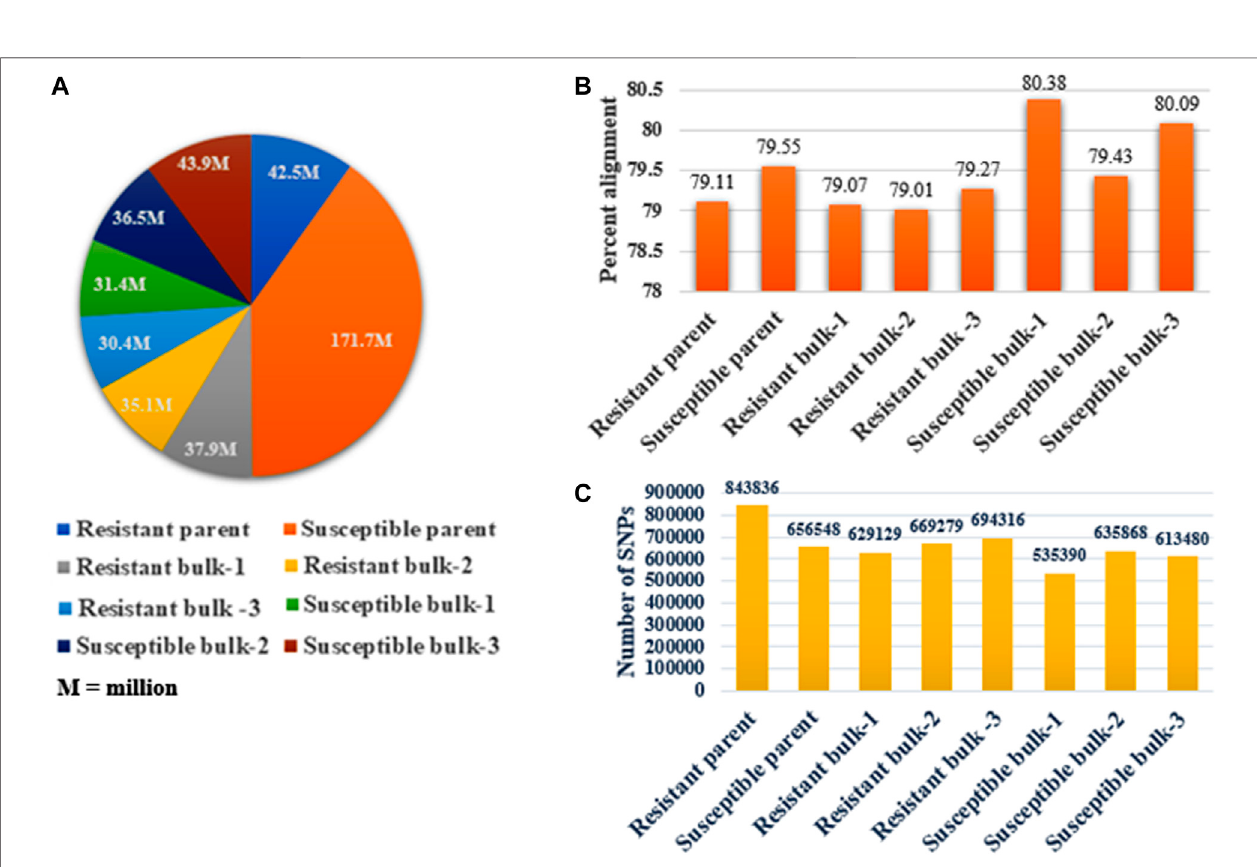
FIGURE 2 | RNA-Seq data study in parents and bulk samples. (A) The number of raw sequence reads (76 bp/read pair) generated in resistant and susceptible parentsandbulk samples. (B) Thepercentage alignmentoftheread tothewheatreference sequence. Susceptiblebulk-1shows thehighestalignment.BWAwasused to align the reads. (C) The total number of SNPs obtained in each sequenced sample and the maximum number of SNPs present in the resistant parent.